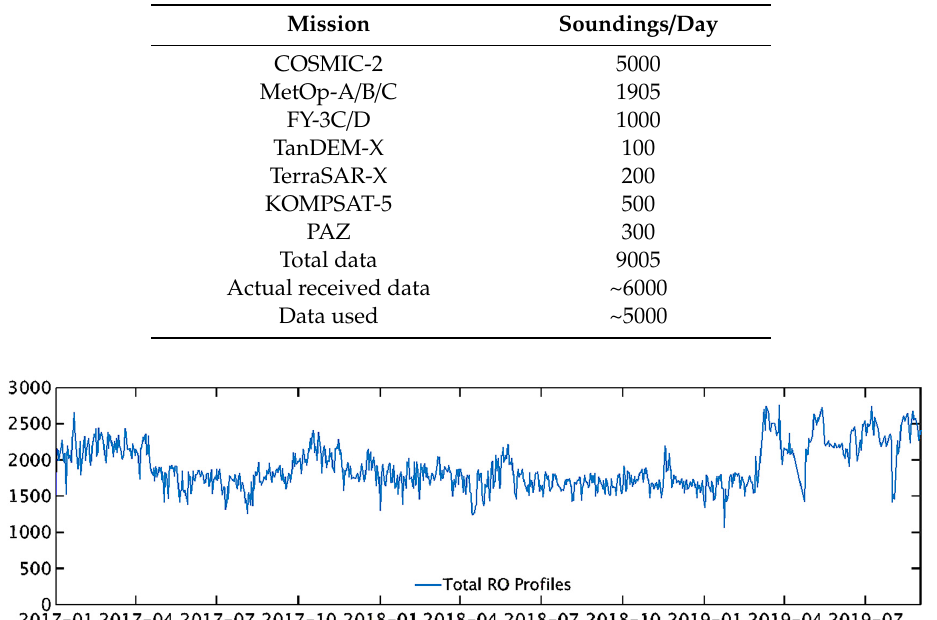
Table 1. Assimilated radio occultation (RO) data in the European Center Medium-Range Weather